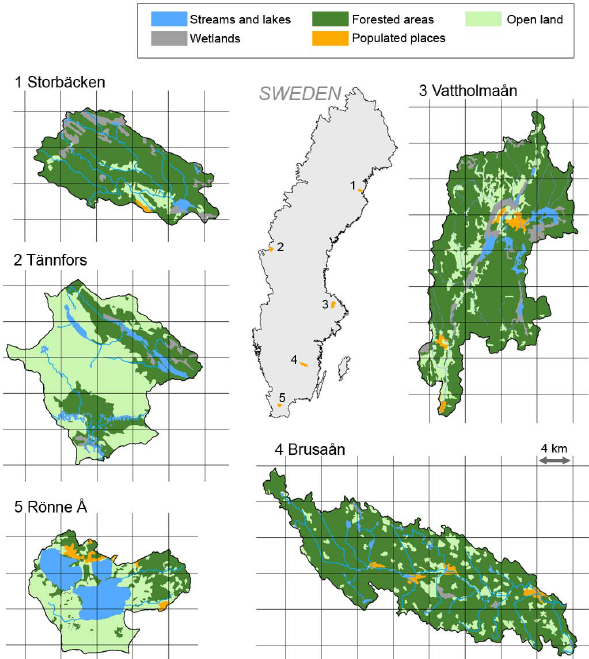
Fig. 2. Map showing locations of the Swedish study sites and the spatially interpolated 4km × 4km national grid of observed precip- itation and temperature. Catchments: (1) Tännfors, (2) Storbäcken, (3) Vattholmaån, (4) Brusaån and (5) Rönne